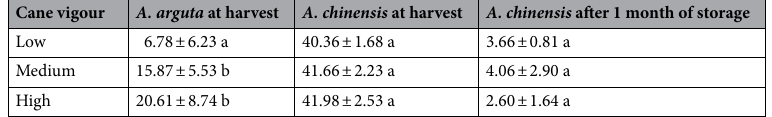
Table 4. Average fruit firmness (mean ± SE, in N) of A. arguta and A. chinensis . Mean values followed by the same letter within a column do not differ significantly.